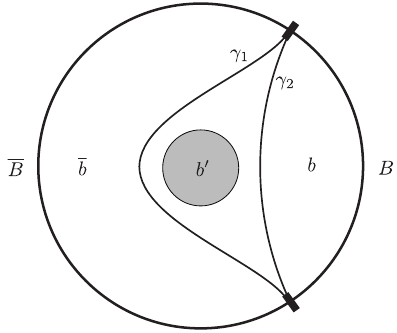
Figure 1: An AdS / CFT setup without complementary state-independent recovery. Between the two candidate extremal surfaces lies a black hole with horizon